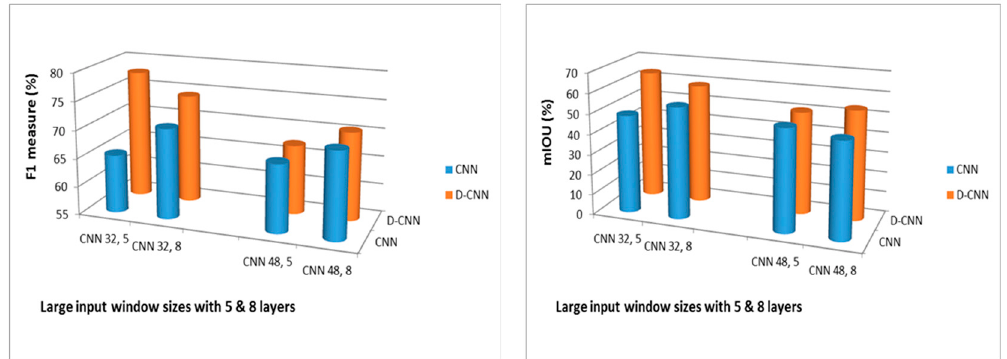
Figure 13. Differences between CNNs and deeper CNN methods (D-CNNs): F1 measure (left) and mIOU (right) for large input window sizes and 5 and 8 layer datasets.